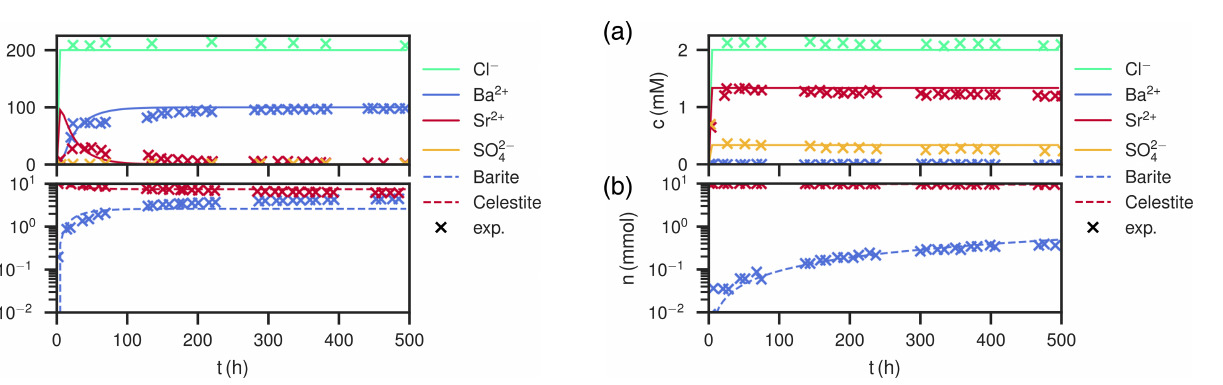
Figure 8. Comparison of experimental (Poonoosamy et al., 2020) Figure 6. Comparison of experimental (Poonoosamy et al., 2020) and simulation results for barium input concentration Ba 2 + = and simulation results for barium input concentration Ba 2 + = 1mM. (a) Breakthrough curves of the effluent, i.e., the chemical 100mM. (a) Breakthrough curves of the effluent, i.e., the chemi- composition (Ba 2 + , SO 2 − , Sr 2 + , Cl − ) of the last cell over the cal composition (Ba 2 + , SO 2 − , Sr 2 + , Cl − ) of the last cell over the 4 4 course of the experiment. (b) Total barite and celestite phase amount course of the experiment. (b) Total barite and celestite phase amount in the column over the course of the experiment. in the column over the course of the experiment.